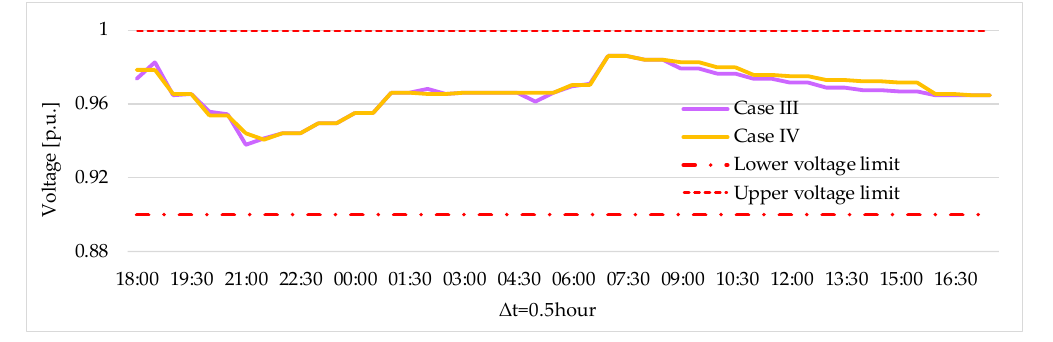
Figure 12. Minimum and maximum voltages for Cases I and II.